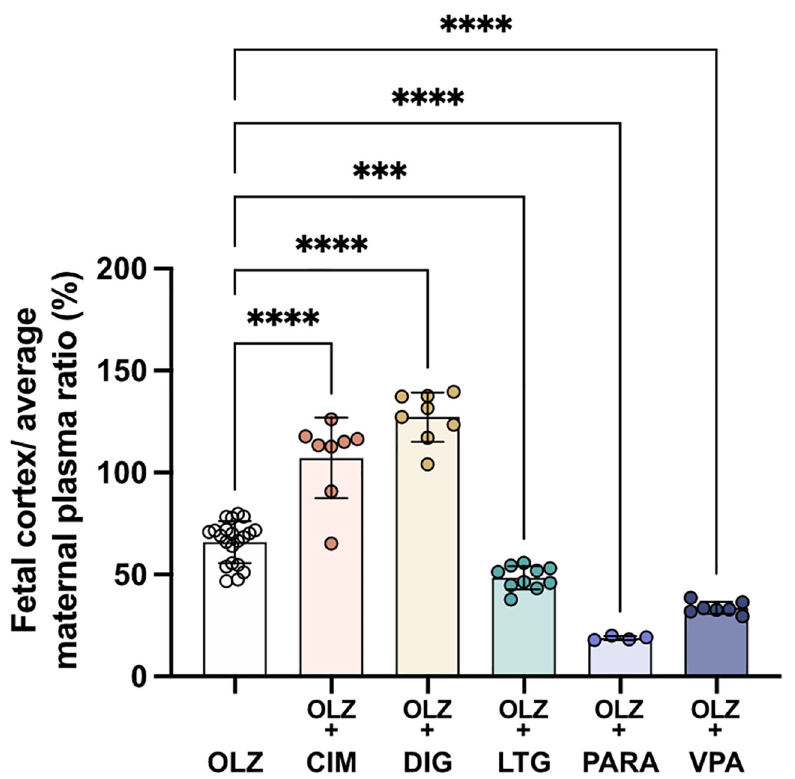
Figure 11. Transfer of [ 3 H]-olanzapine across the placenta and into the fetal brain cortex. Calculated by fetal cortex/average maternal plasma ratio (%) after a single intravenous ( i.v. ) injection either as monotherapy or in combination with: cimetidine (CIM, 11 mg/kg), digoxin (DIG, 0.03 mg/kg), lamotrigine (LTG, 6 mg/kg), paracetamol (PARA,15mg/kg)orvalproate(VPA,30mg/kg).Barsaremeans (cid:3) SD.Noteeachpointisanindividualanimal(n=4 – 21). ***p<0.001,